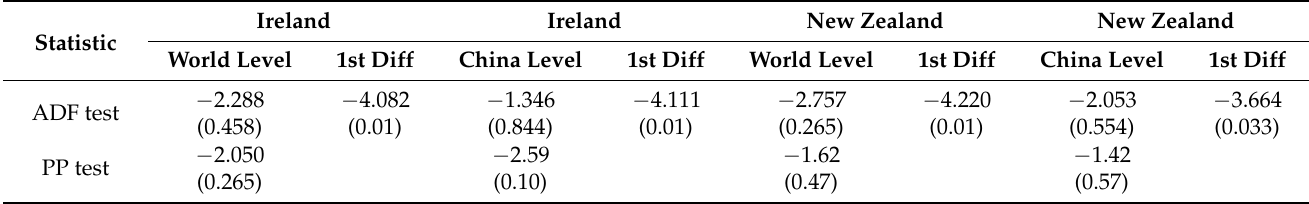
Table 2. The unit root tests results for the export prices of Ireland and New